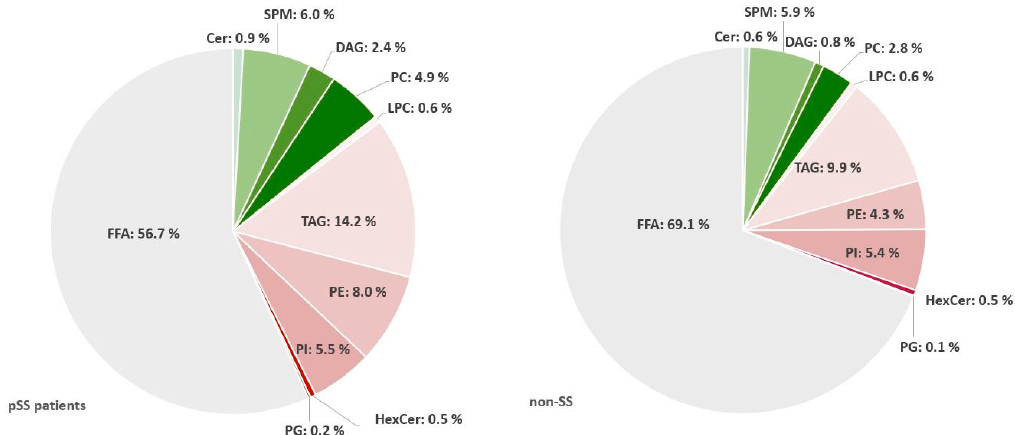
Figure 4. Total distribution of lipid concentration in biopsies. pSS: primary Sjögren’s syndrome; nonSS: non-Sjögren’s syndrome; FFA: free fatty acids; Cer: ceramide; SPM: sphingomyelin; PC: di- acylglycerophosphocholine; DAG: diacylglycerol; LPC: lysophosphatidylcholine; TAG: triacylglyc- erol; PE: diacylglycerophosphoethanolamine; PI: diacylglycerophosphoinositol; HexCer: hexo- sylceramides; PG: phosphatidylglycerol. Significant differences in individual lipids between glands from pSS patients compared to non-SS sicca subjects were observed in PI, SPM (both p < 0.05), and TAG ( p < 0.01).